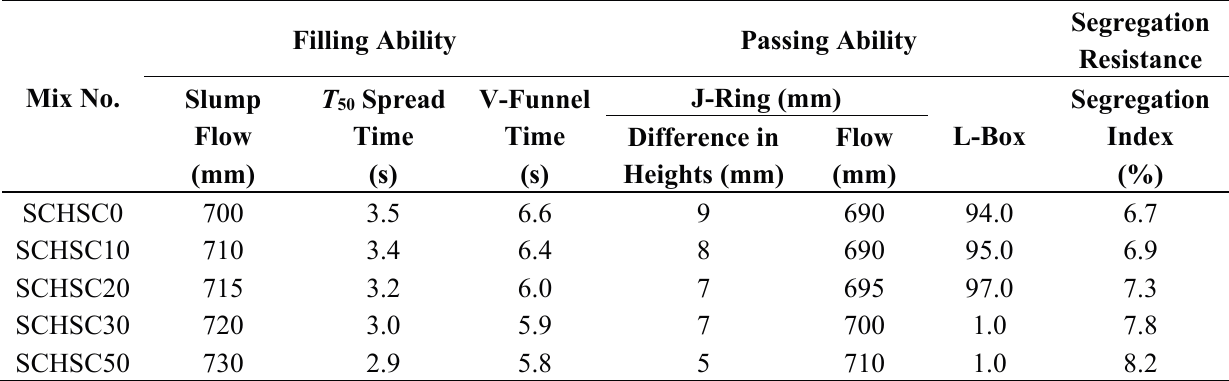
Table 4. Fresh properties of concrete.